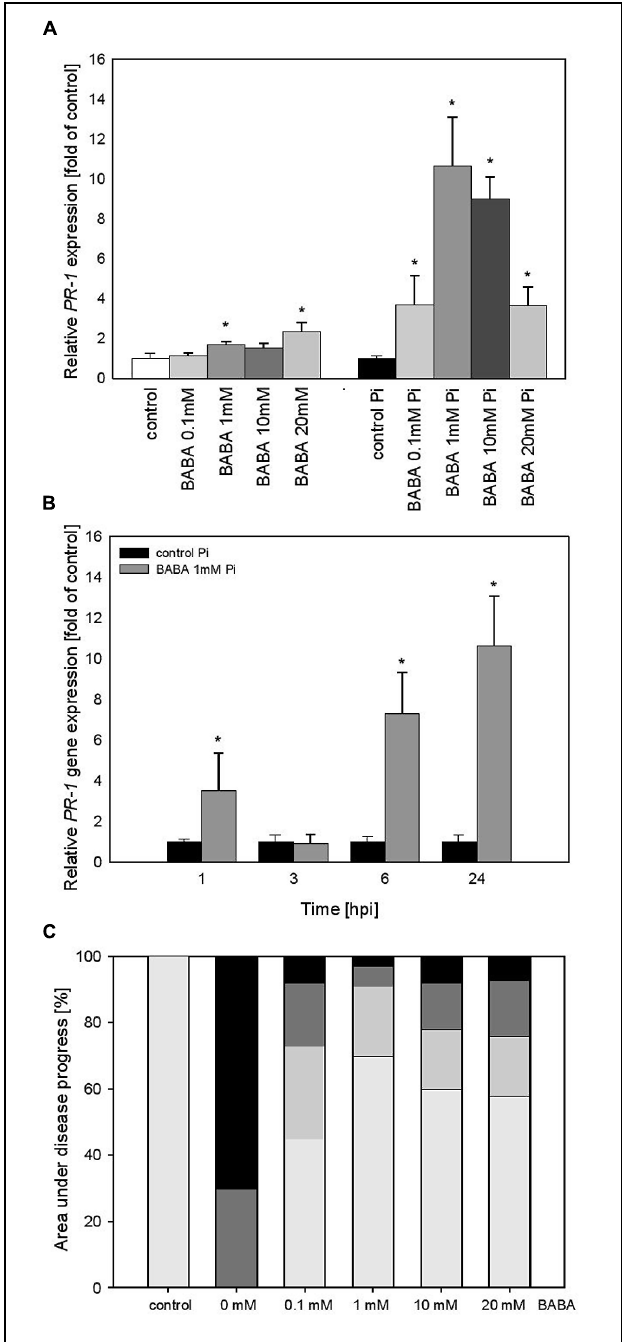
FIGURE 3 | PR-1 gene transcript accumulation and BABA dose-dependent protection against P. infestans in the flowering stage (B 0 /B 1 ) of BABA-treated parent plants. (A) PR-1 gene transcript accumulation 28 days after induction with BABA (left bars) and after inoculation of previously immunized plants (at 24 hpi; right bars), (B) a time-dependent analysis of PR-1 gene expression in P. infestans -inoculated plants previously treated with 1 mM dose of BABA (28 days earlier). (C) disease development index at 7 dpi in the BABA-treated parents in flowering stage (B 0 /B 1 ). ∗ Significantly different from control leaves, P < 0.05. Values represent the means of data ± SD of at least three independent experiments, each with at least three biological replicates.